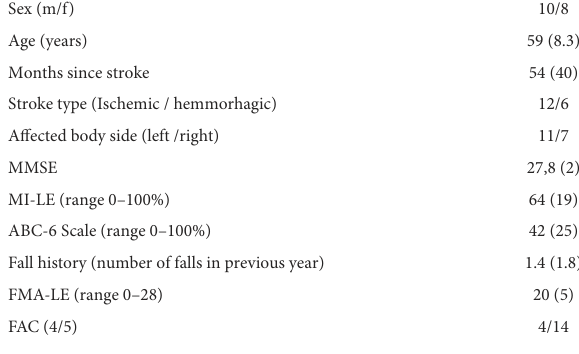
TABLE 1 Participant characteristics ( n =